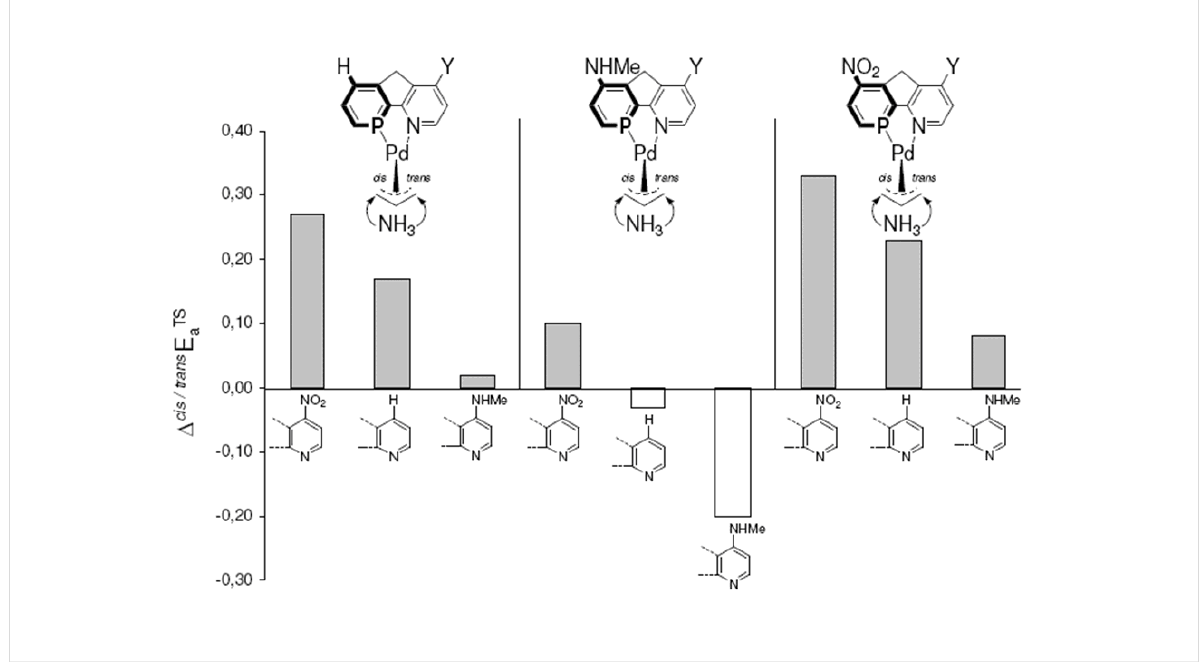
Figure 9: For each phosphabenzene moiety, the site selectivities ΔE aTS increase with more electron withdrawing pyridine substituents (Y) in the order HNMe < H < NO 2 (cf. Table 1).